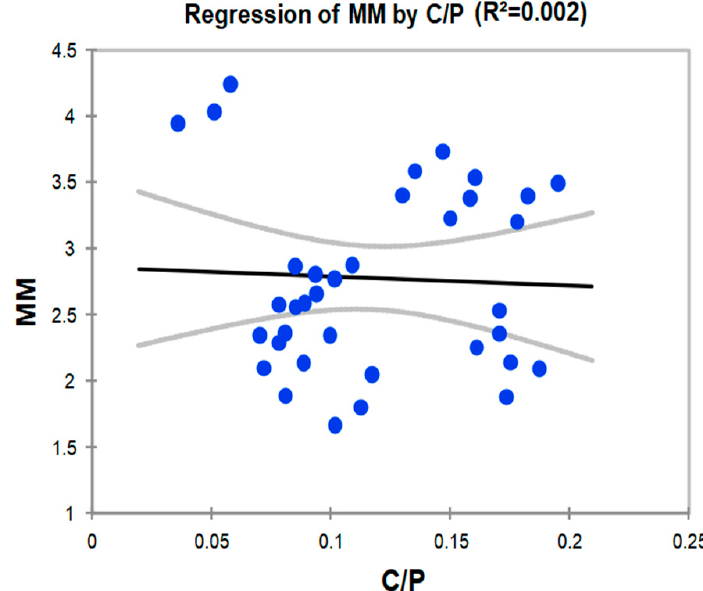
Figure 5. Correlation between C/P and MM indexes calculated for the archaeological human and modern ruminant bones from the Fewet oasis in the Sahara of SW Libya. The central black line represents the regression line of the fitted model; grey lines represent the 95% confidence interval. Then, the statistical significance of the association between the burial area and the spectral parameters of all samples was determined using the ENV category as the reference (Table 3). No significant effect of the burial area was detected for amide I/PO4 and MM parameters (significance > 0.05). With regards to the C/P ratio and FWHM 603 , a significant effect was highlighted only for BA2 and BA3 (significance < 0.05), while for the IRSF index, a significant effect was found only for BA1 and BA3 categories (significance < 0.05). Overall, these data confirmed that the chemical and structural features of carbonated hydroxyapatite were different among the samples according to the burial area